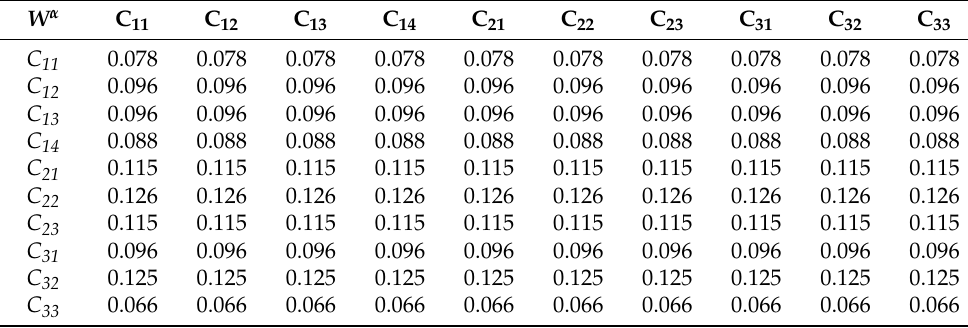
Table 7. Weighted supermatrix W α